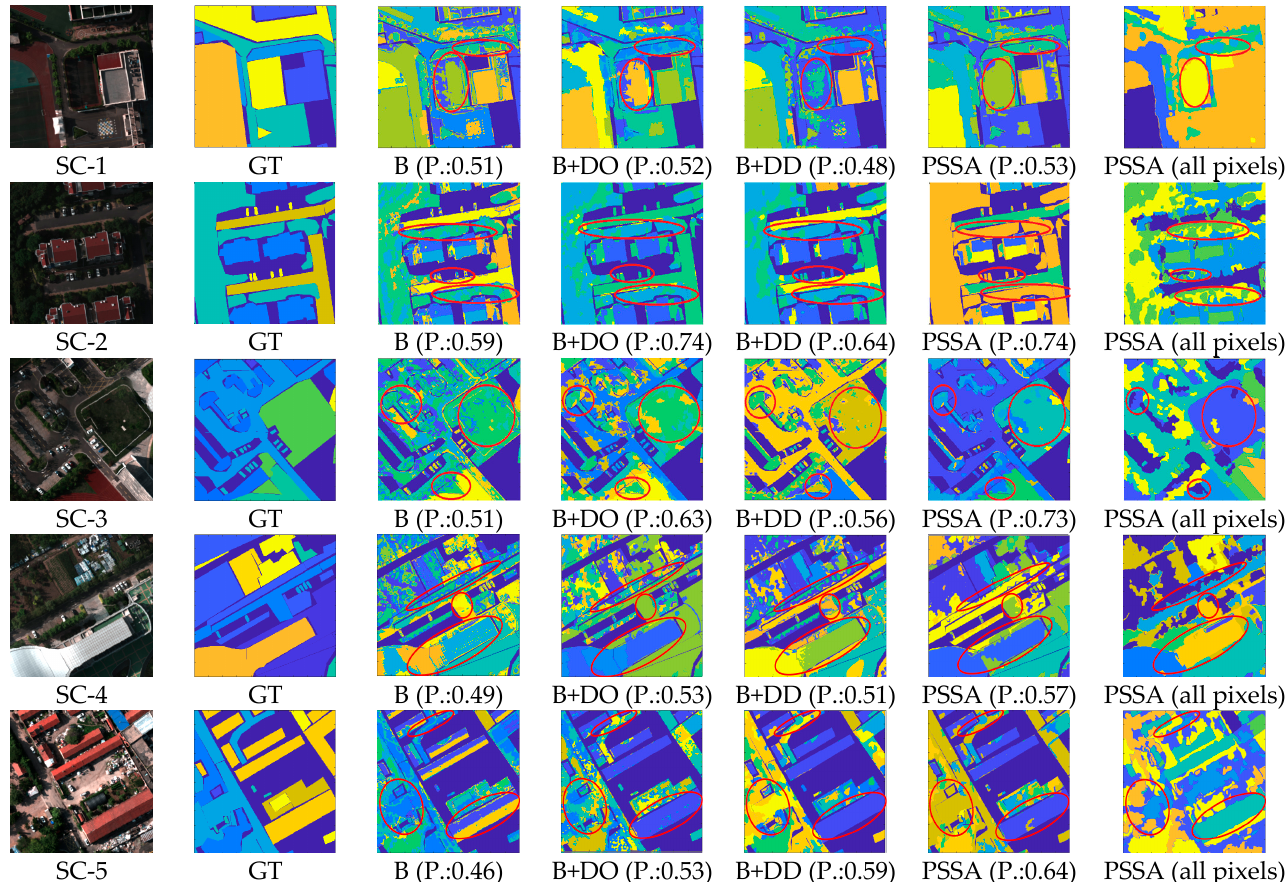
Figure 7. Original images of SC-1 to SC-5, their ground truths and the classification results in different steps. All the results are for labelled pixels only, except the last one from our approach. Areas in red circles in each row are for particular attention to compare the results of classification.